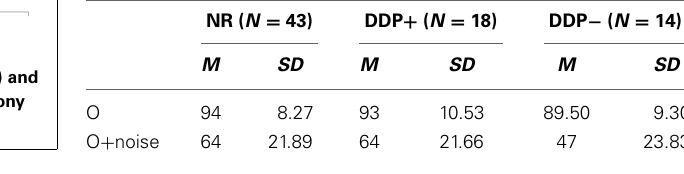
and signal + noise (O + noise).